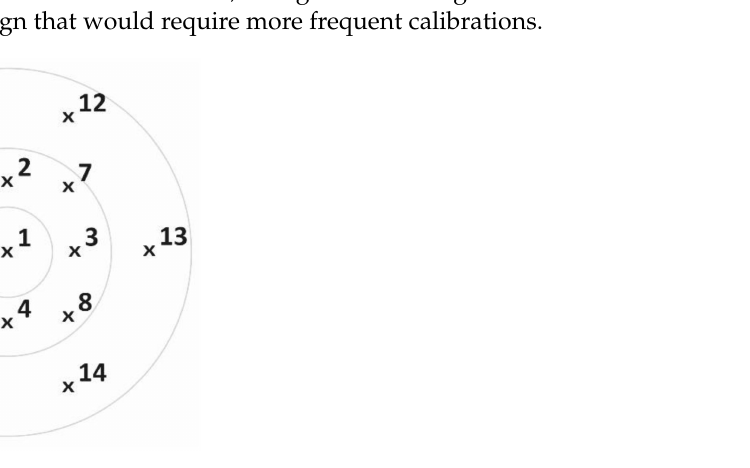
Figure 6. Placement of the fifteen containers in which the amount of water collected was measured.